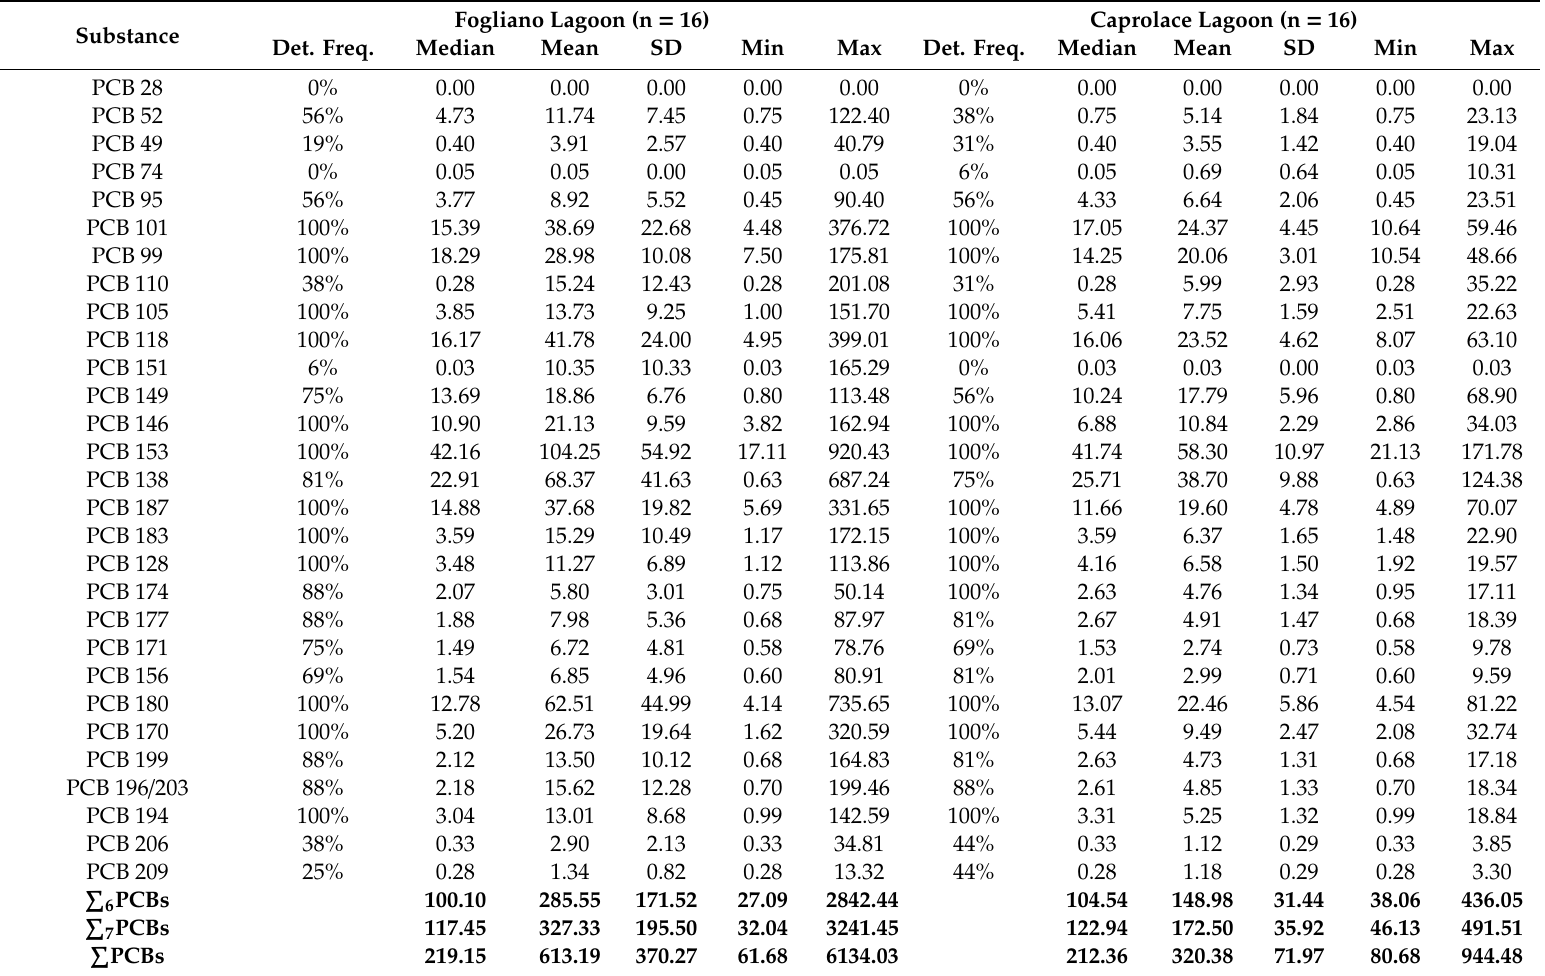
Table 3. Detection frequencies, medians, mean concentrations ( ± SD) and ranges of organic compounds (ng g − 1 lw) analyzed in C. labrosus muscle from Fogliano and